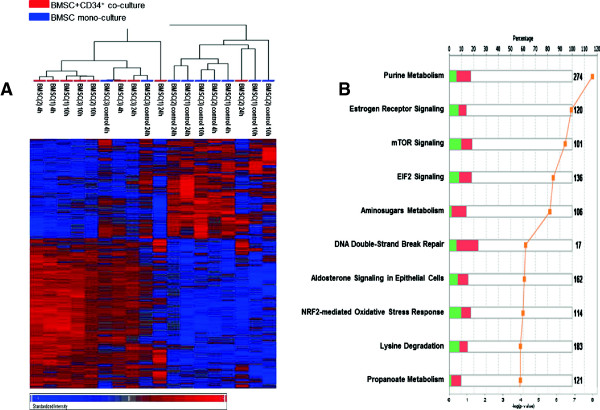
Gene expression analysis of BMSCs co-cultured with CD34+ cells compared with BMSC mono-cultures shows changes in metabolism related genes. (A) Hierarchical cluster analysis of 4904 differentially expressed genes in BMSCs co-cultured in transwells with CD34+ cells from three healthy donors compared with BMSC mono-cultures (control) using Partek Genomic Suite program (ANOVA test with unadjusted p-value < 0.05). The displayed colors represent the fold changes with the shades of red and blue indicating up- and down-regulation respectively. The color key for the sample labels is on the top left. (B) Ingenuity Pathway Analysis (IPA) of the 4904 differentially expressed BMSC genes. Numerical symbols at the right side of each bar indicate the total number of genes in each pathway. The bars indicate the percentage of up- (red bar) and down-regulated (green bar) genes in each pathway, while the orange line indicates minus-log transformed p-value. The top 10 canonical pathways are shown.